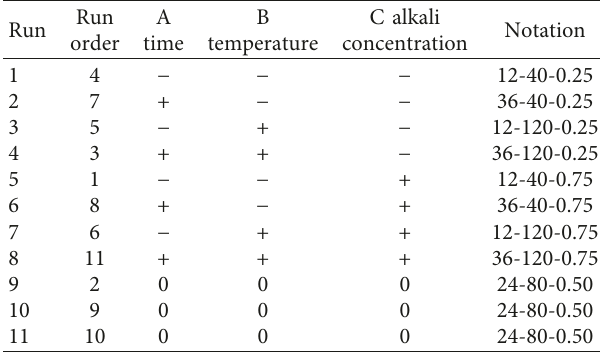
Table 2: Experimental 2 3 factorial design with three center points